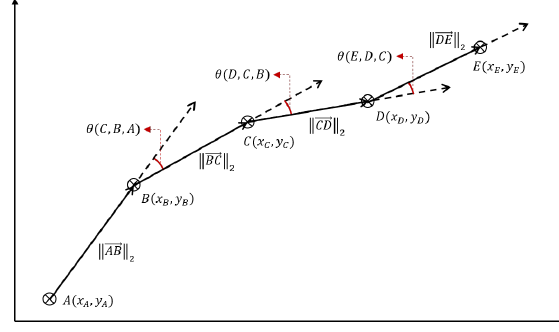
Figure 4. An example of deriving a future